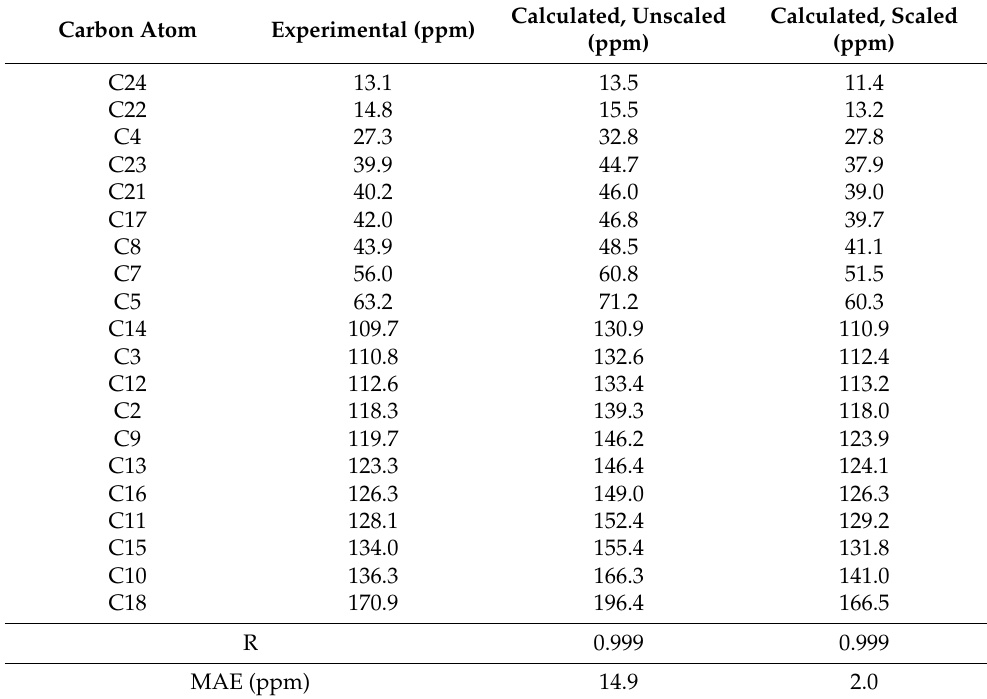
Table 2. Experimental and theoretical (at M05-2X/6-311++G(d,p) level of theory) 13 C chemical shifts of LSD in chloroform. Calculated, Carbon Atom Experimental (ppm)